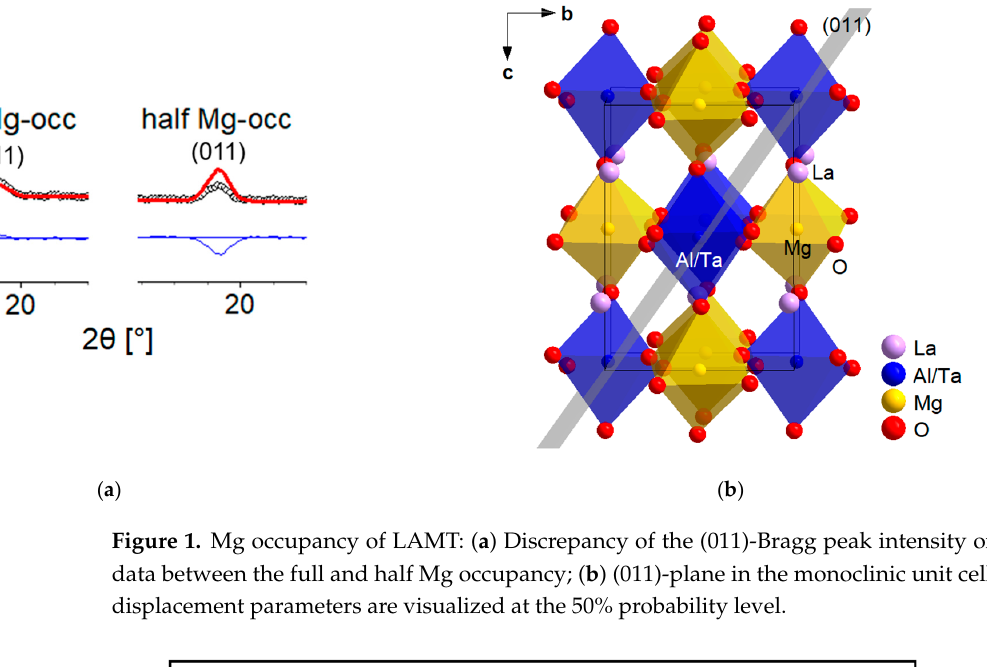
Table 1. Results of combined Rietveld analysis on LAMT. X-ray